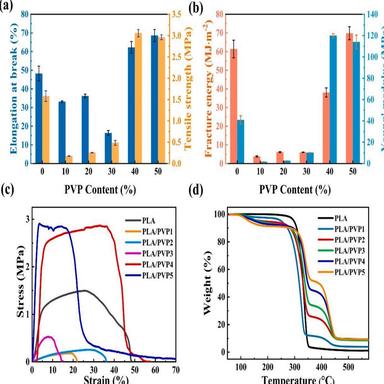
Mechanical properties and thermal stability of PLA/PVP crosslinked nanofiber membranes: (a) Fracture energy and Young's modulus, (b) Elongation at break and Tensile strength, (c) Stress-strain curve and (d) TGA curve.